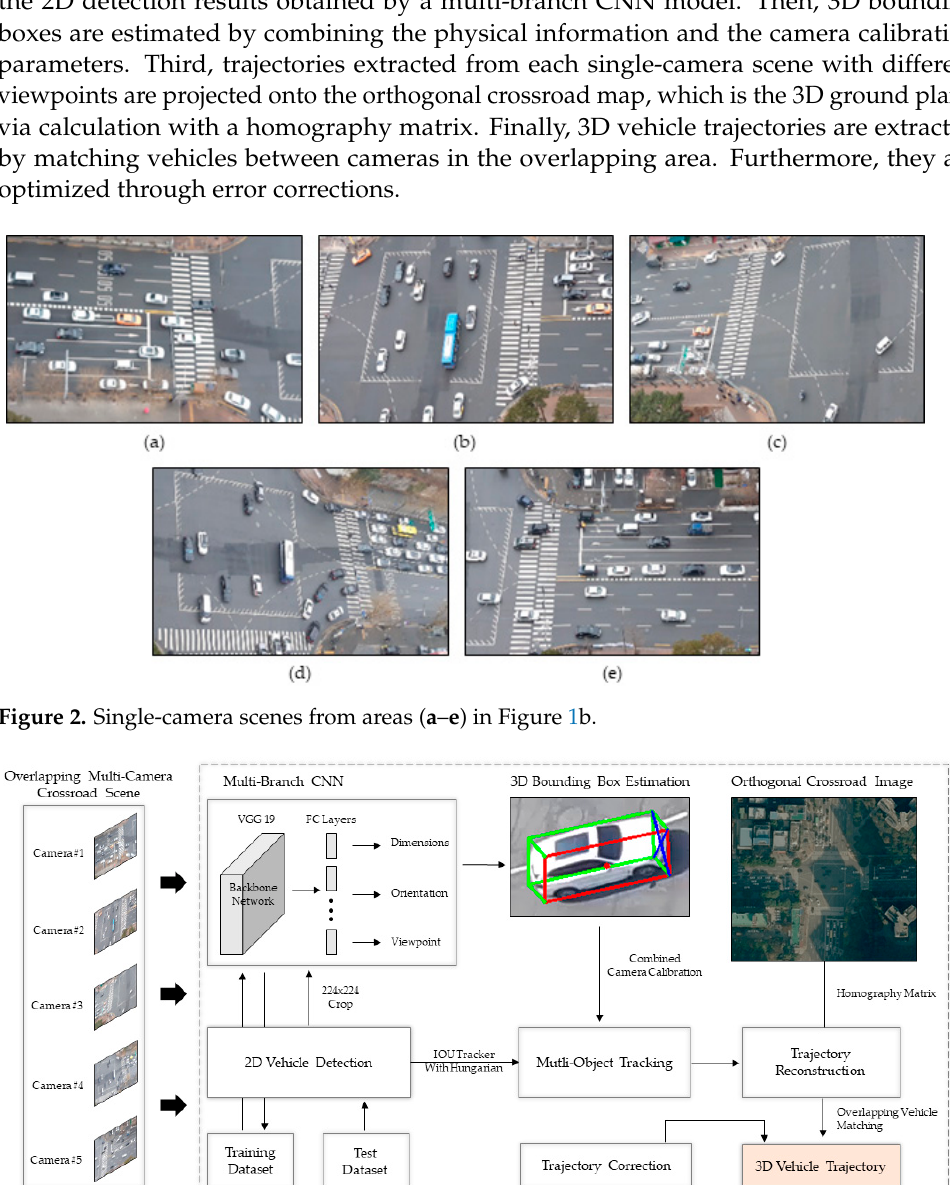
Figure 3. The overall flow chart of the proposed method in this